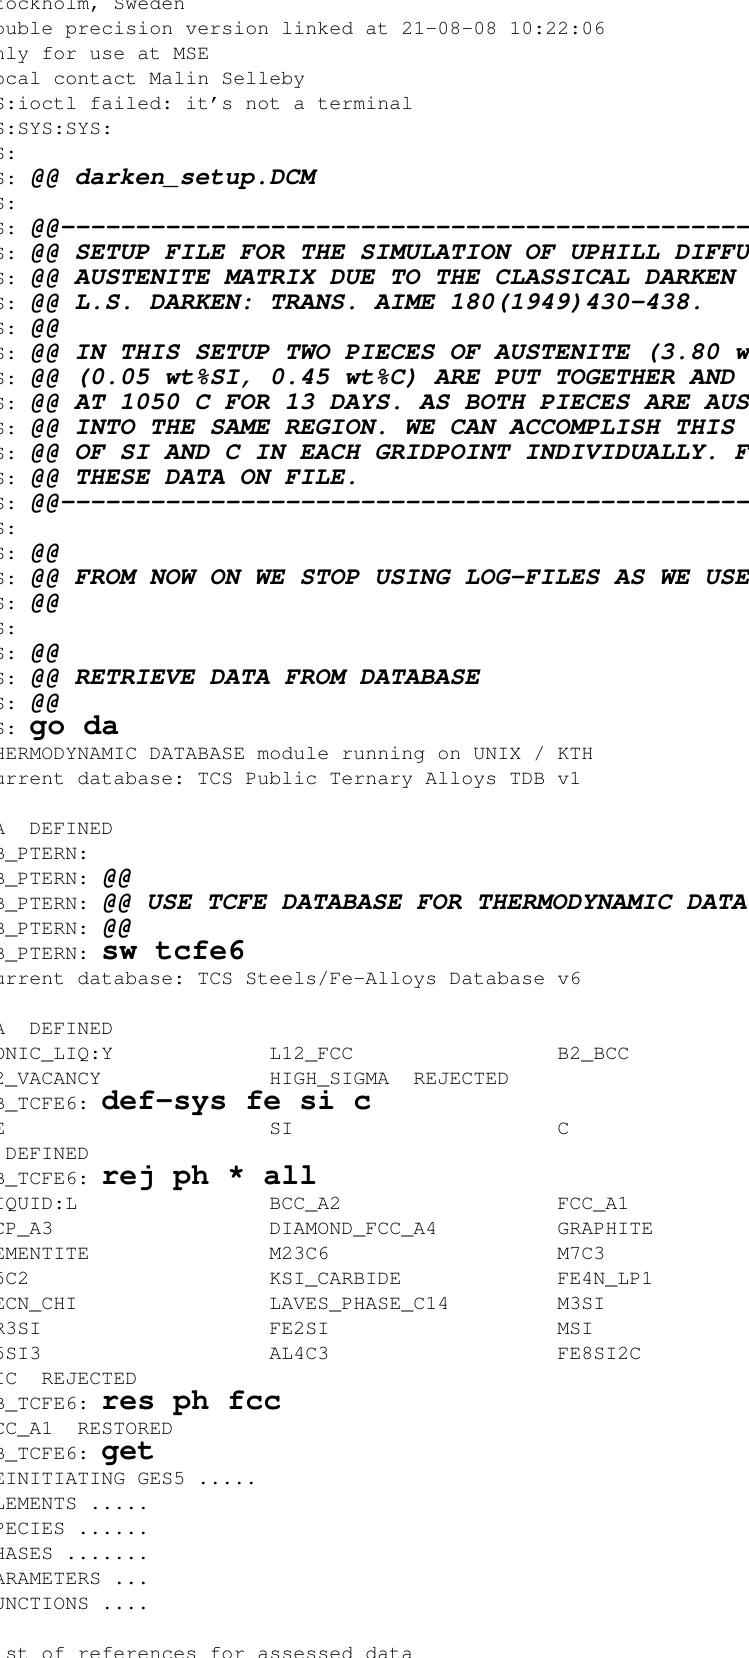
Stockholm, Sweden Double precision version linked at 21-08-08 10:22:06 Only for use at MSE Local contact Malin